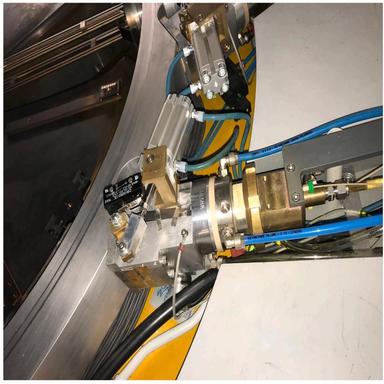
Detailed view of the characterized target attached to the vacuum chamber of the accelerator. The disassembled target view can be found in.